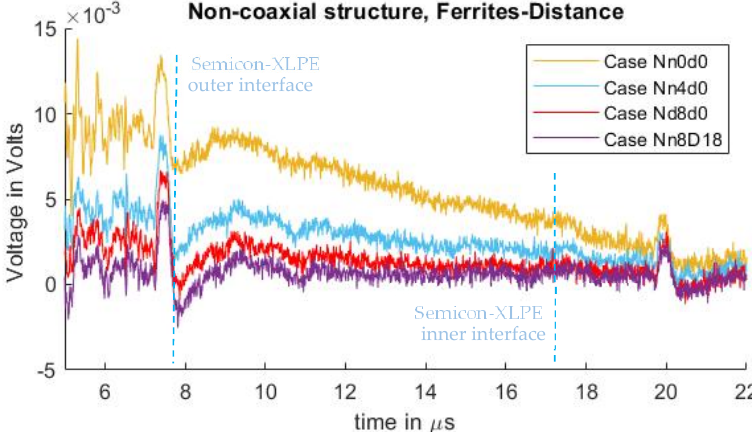
Figure 10. Comparison of measured signals with different semiconductor distances “ d ” combined with several ground path inductances.